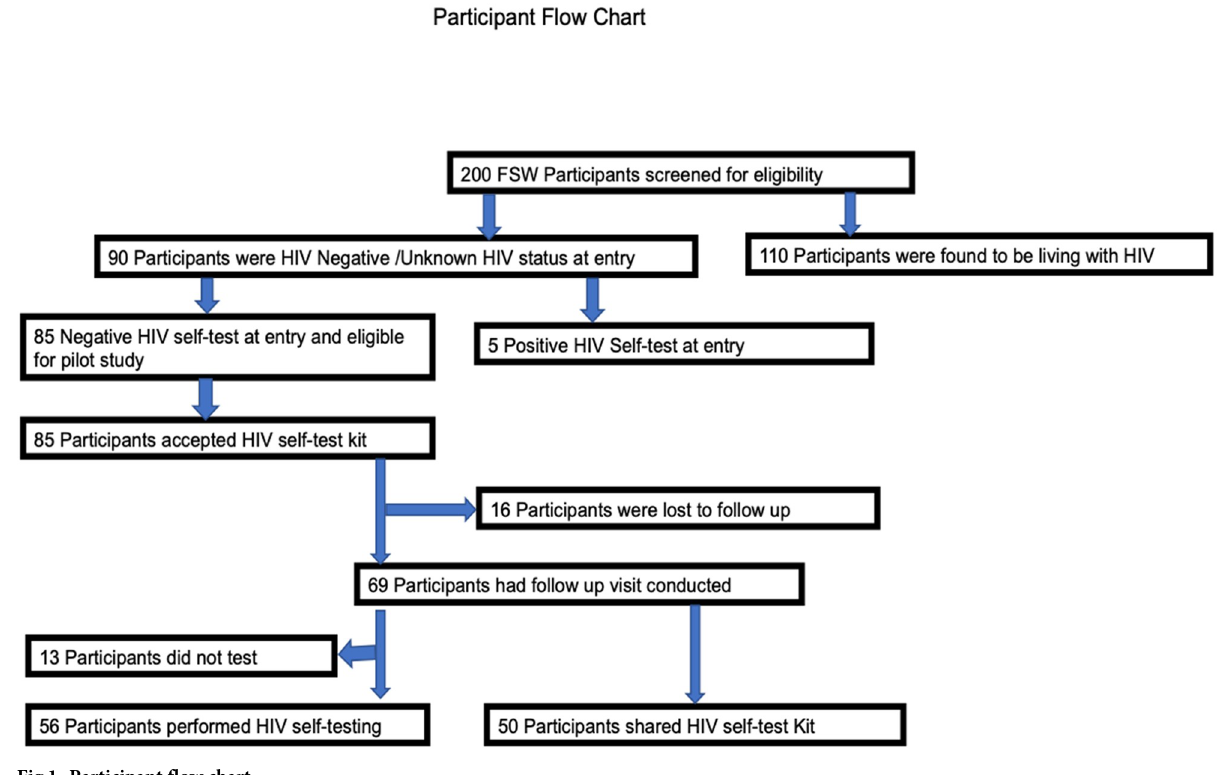
Fig 1. Participant flow